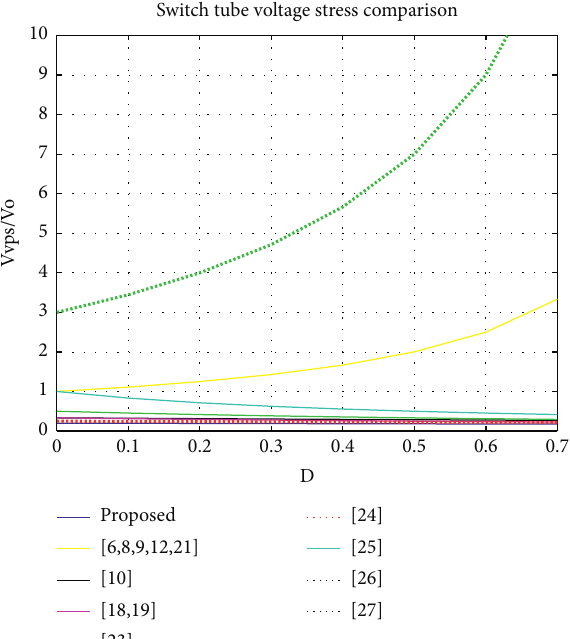
Figure 10: Voltage stress comparison curve of converters’ switches.